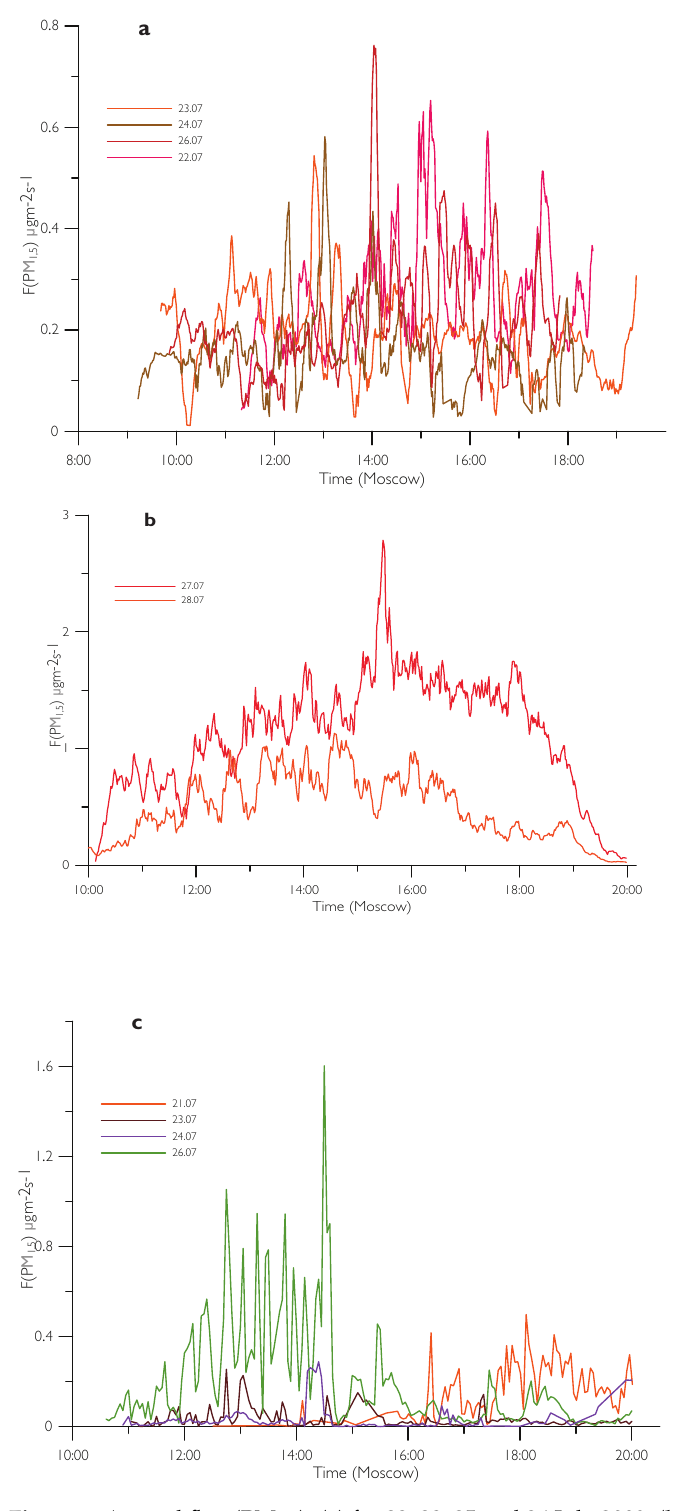
Figure 9. Aerosol flux (PM 1.5 ): ( a ) for 22, 23, 25 and 26 July 2009; ( b ) for 27 and 28 July 2011; ( c ) for 21, 23, 24 and 26 July 2013.